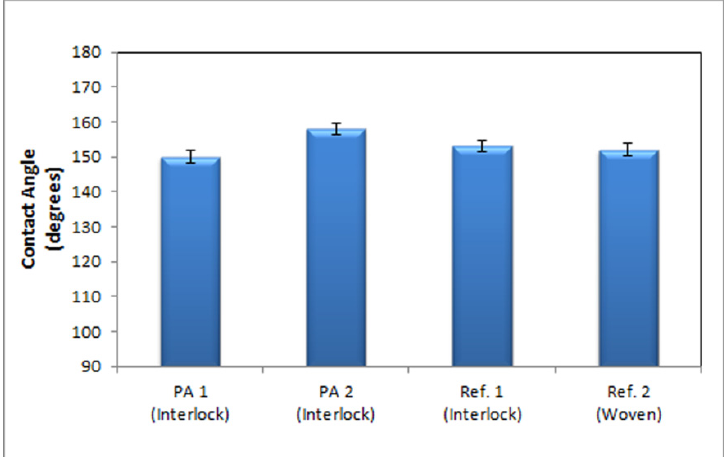
Figure 5. Comparison of contact angles for treated and commercial reference samples.